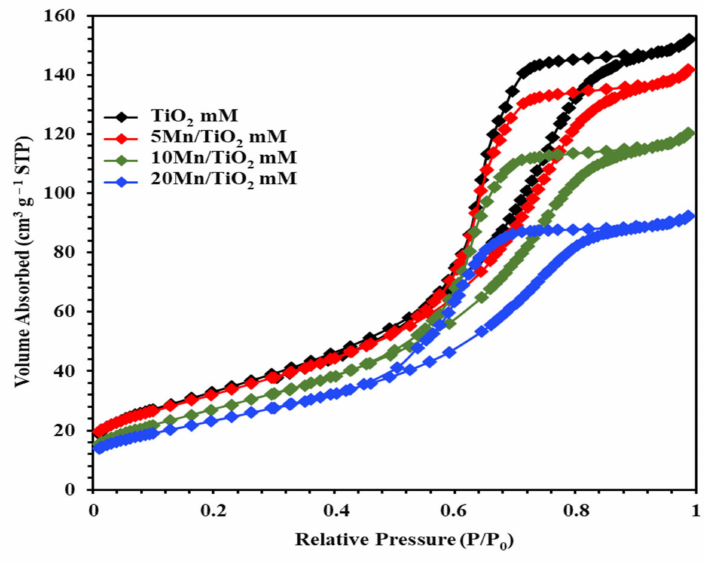
Figure 2. N 2 adsorption–desorption isotherms for the meso–macrostructured TiO 2 mM support and the corresponding supported Mn/TiO 2 mM samples (5, 10 and 20 Mn